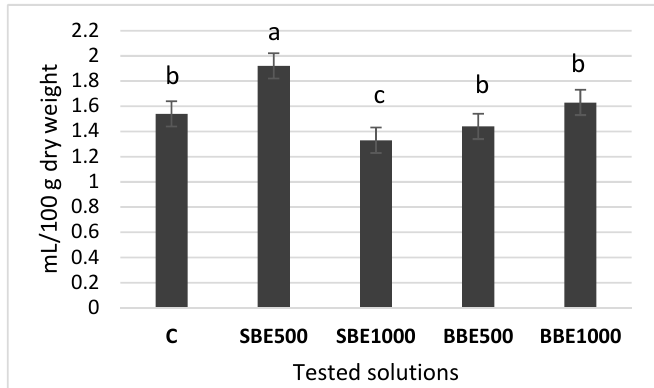
Figure 3. Volatile oil content from Lavandulae flos (mL / 100 g dry weight); C—Control, SBE500—spruce bark extract at 500 mg dry bark / 100 mL solvent, SBE1000—spruce bark extract at 1000 mg dry bark / 100 mL solvent, BBE500—beech bark extract at 500 mg dry bark / 100 mL solvent, BBE1000—beech bark extract at 1000 mg dry bark / 100 mL solvent. Di ff erent letters (a, b, c) mean statistical significant di ff erences at p < 0.05.